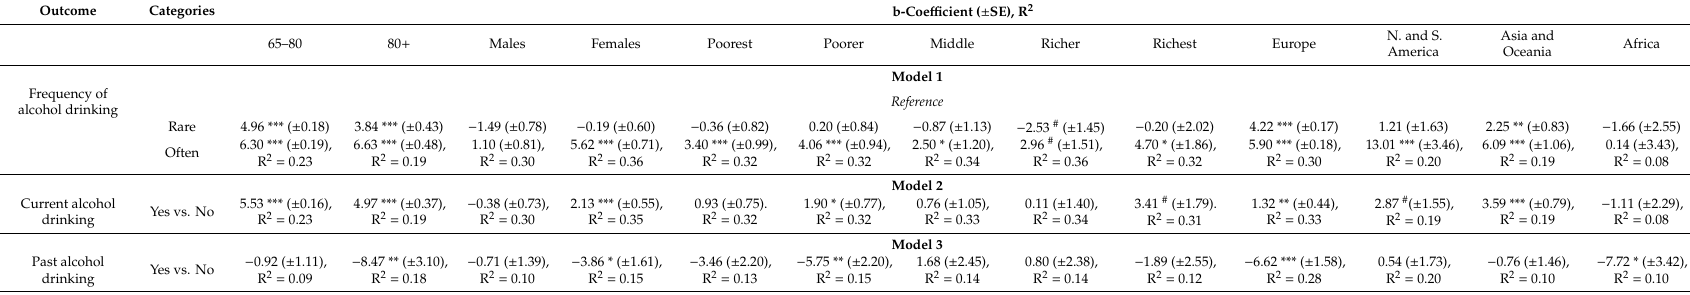
Figure 2. Trajectories of health status metric from the ages of 65 to 95 + years old by frequency of alcohol drinking for males ( A ) and females ( B ). Healthy ageing metric ranges from 0–100. Table 3. Pooled estimates of the association between healthy ageing and the alcohol intake estimated in the overall sample, by age group, by gender, by wealth status and by